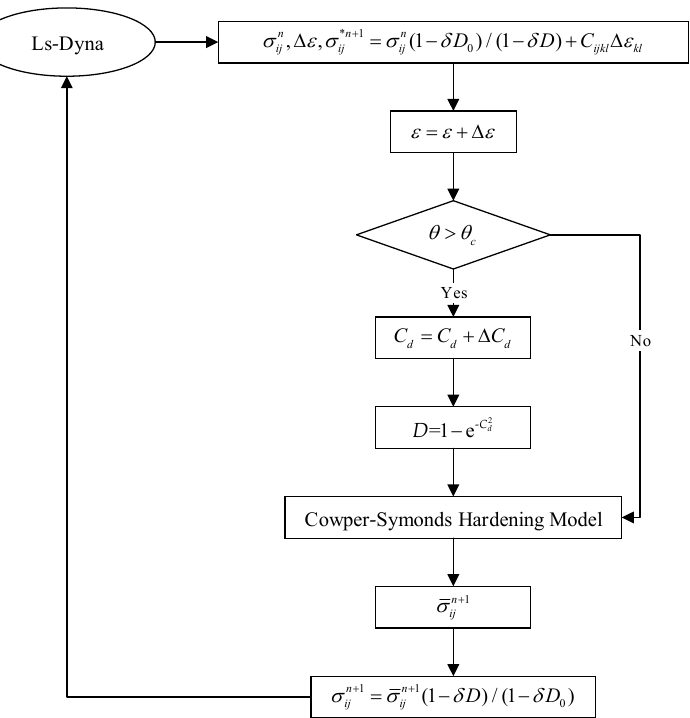
Figure 1. Coupling between the Cowper ‐ Symonds hardening model and the proposed damage model.